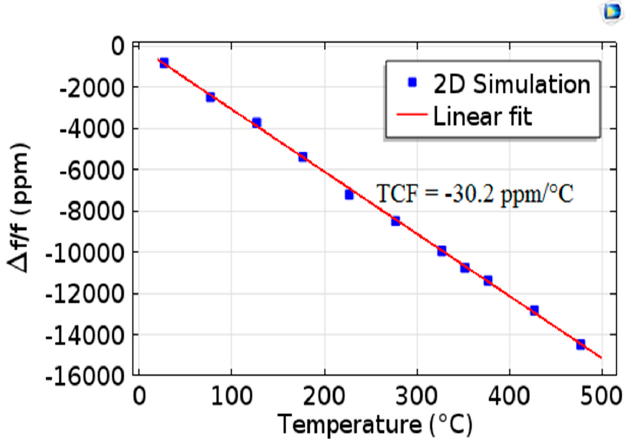
Figure 9. Relative evolution of the resonant frequency as a function of temperature.